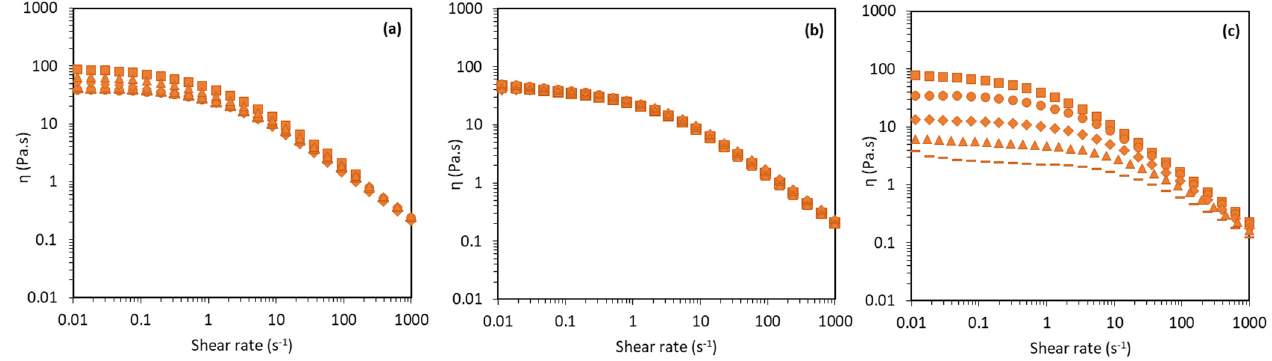
Figure 4. Flow curves of d-FucoPol aqueous solutions. ( a ) Effect of ionic strength: 0.1 M (dashed line), 0.5 M (circles), 1.0 M (diamonds), 2.0 M (triangles), and 3.0 M (squares). ( b ) Effect of pH: 3.6 (triangles), 4.8 (squares), 6.2 (circles), 8.5 (diamonds), and 11.5 (dashed line). ( c ) Effect of temperature: 10 °C (squares), 25 °C (circles), 45 °C (diamonds), 65 °C (triangles), and 80 °C (dashed line).